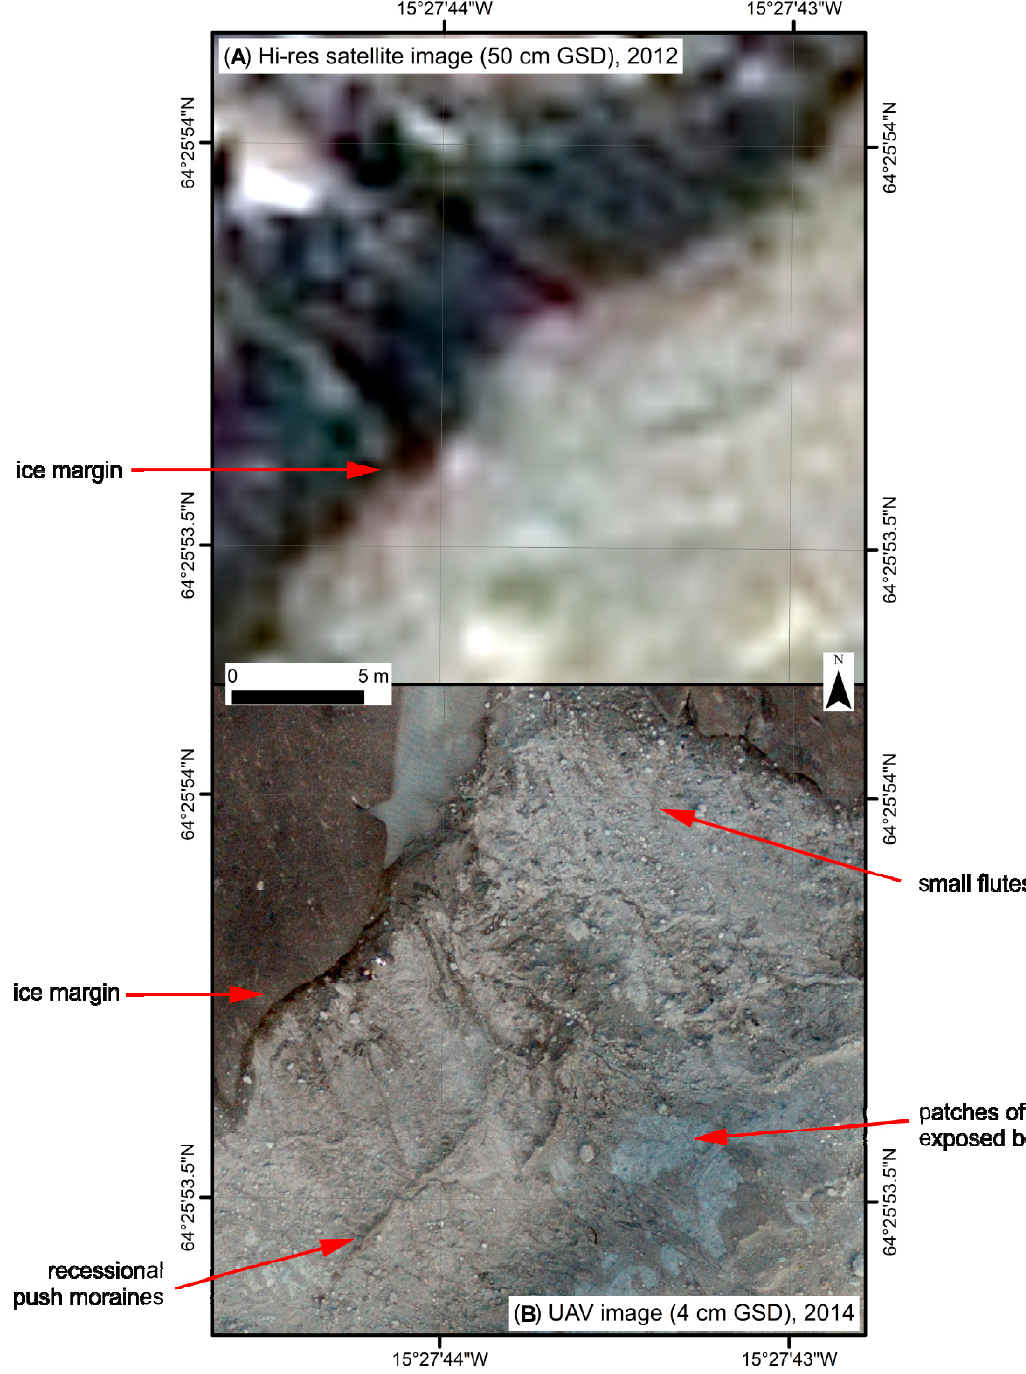
Figure 1. A comparison of very-high resolution satellite imagery (World-View 2, 50 cm ground sampling distance (GSD)) and UAV-derived imagery (4 cm GSD) on the foreland of Hoffellsjökull, Iceland. Note that the UAV-derived data allowed for recognition of the subtle annual push moraines, thereby, enabling the investigation of previous annual (or seasonal) ice-margin dynamics.